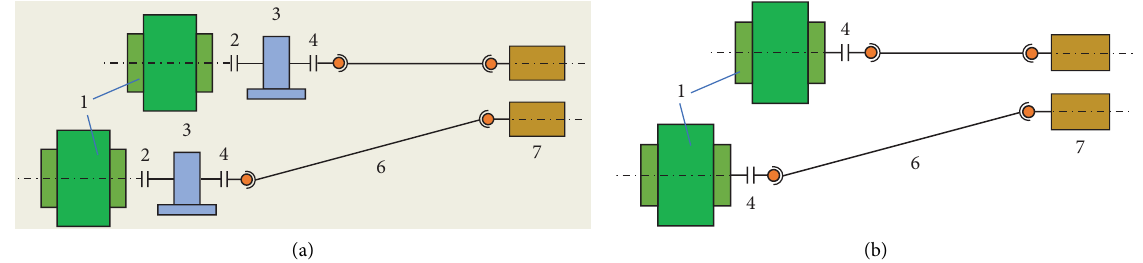
Figure 2: Structure of primary drive device of the reversible rolling mills: (a) with reducer and (b) without reducer.